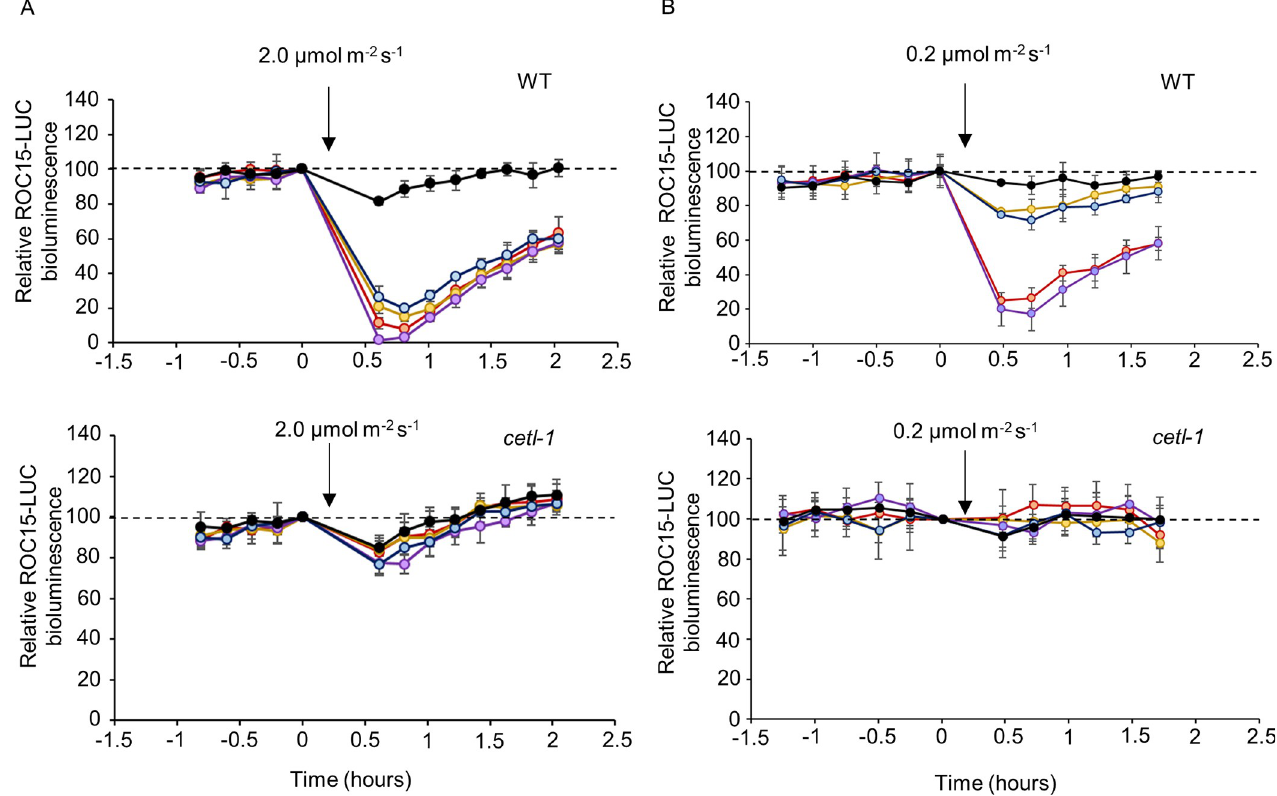
Fig 4. ROC15-LUC light response at different wavelengths in the cetl-1 mutant. Spot cultures on high-salt agar were transferred to 96 well black plates, and bioluminescence was monitored as described in Materials and Methods. Akalumine was used as substrate. Cultures were maintained in darkness for at least 3 hours to allow for the build-up of ROC15-LUC, and then exposed to a 5-minute light pulse (violet, blue, yellow, or red) at two different intensities. A and B . Representative traces of ROC15-LUC bioluminescence in response to light pulses at intensities of 2 μ mol m -2 s -1 and 0.2 μ mol m -2 s -1 , respectively, in WT (top panel) and cetl-1 (bottom panel). Bioluminescence values have been calculated relative to those at the time point just before the light pulse. Mean ± SD of 4 biological replicates are shown. Arrows refer to the approximate time of the light pulse. Each color represents the wavelength of light to which the sample was